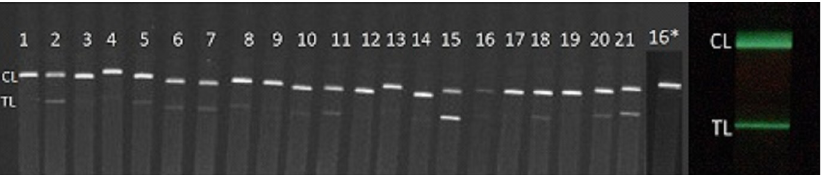
Fig 2. Representative images of the HSV PTH202 serum/plasma panel tested with the HSV-2 PLNP LFA. The strips were imaged as a group on the FluorChem Platform (left side, panel members 1 to 21) or individually on the iPhone platform (right, panel member 2). The images capture a region that encompasses both the test line (TL) and control line (CL) on the test strip. Panel member 16 consistently showed a significantly weaker control line which